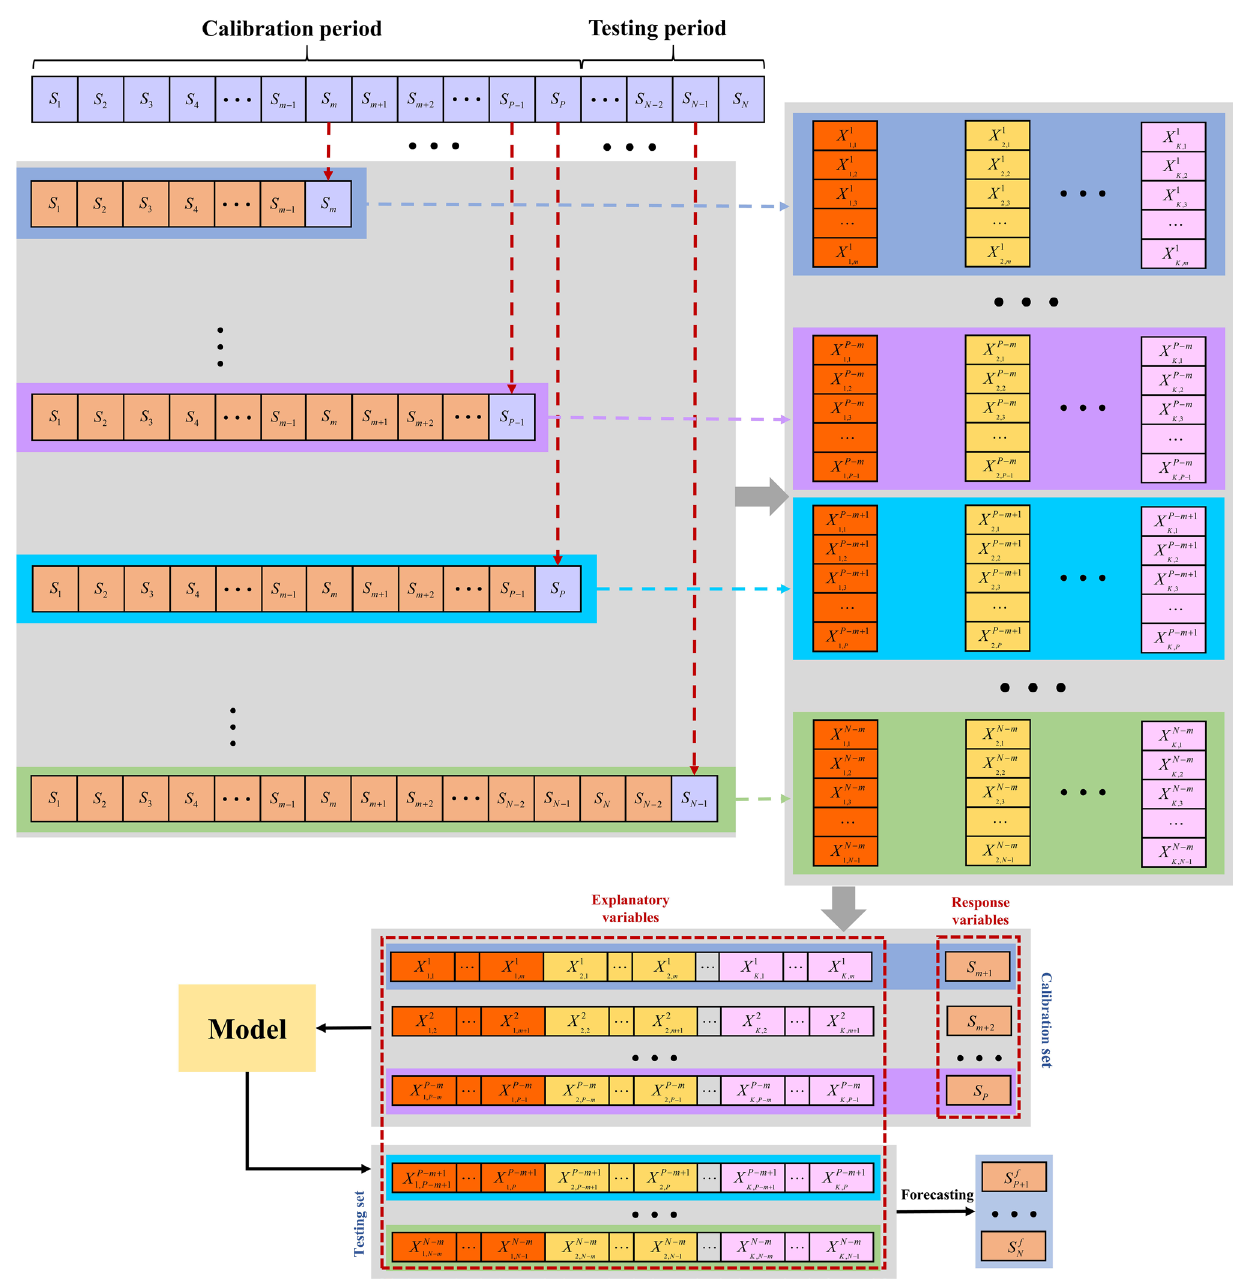
Fig. 5 The process of SMFSD sampling